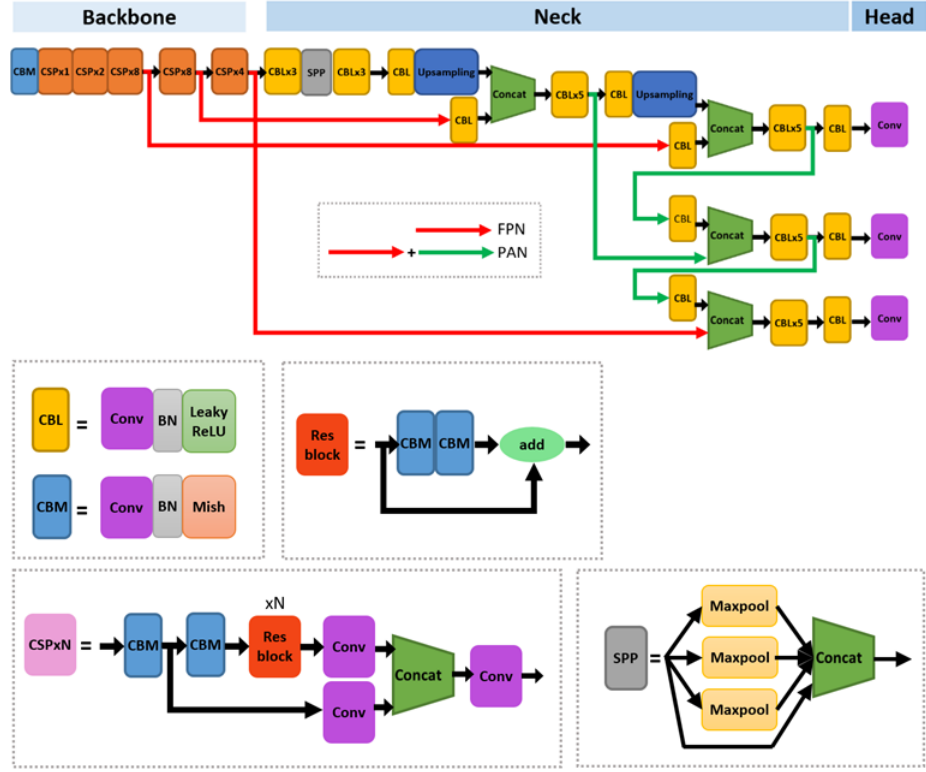
Figure 1. Network architecture of YOLOv4.